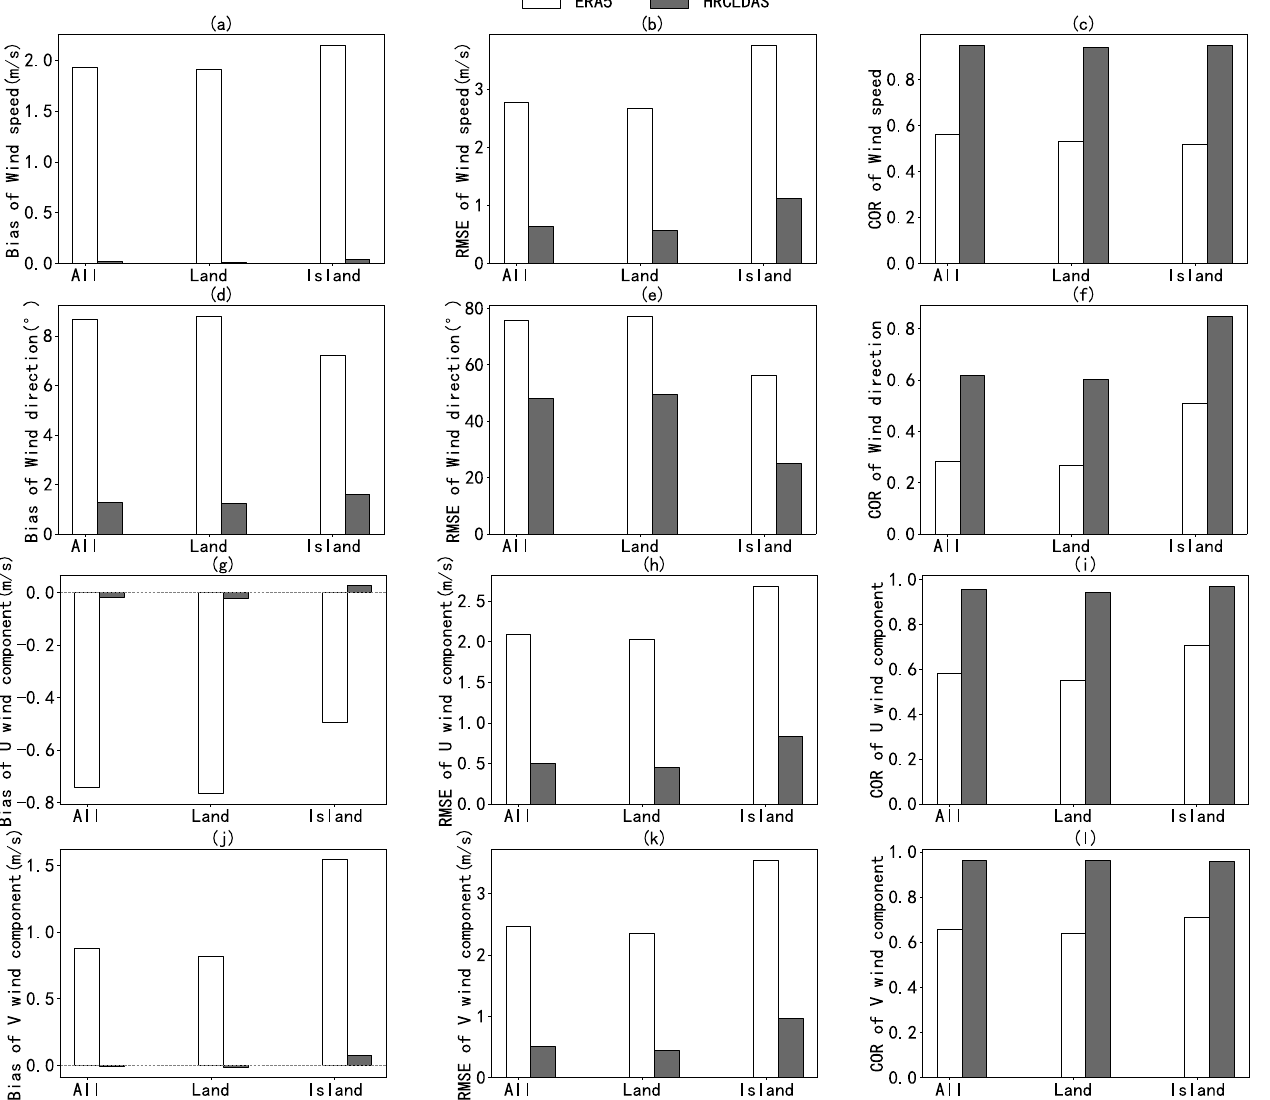
Figure 5. Evaluation indicators of ERA5 and HRCLDAS for land and sea. Bias of near-surface wind speed ( a ), wind direction ( d ), U component ( g ), and V component ( j ); RMSE of near-surface wind speed ( b ), wind direction ( e ), U component ( h ), and V component ( k ); COR of near-surface wind speed ( c ), wind direction ( f ), U component ( i ), and V component ( l ). For wind direction, ERA5 and HRCLDAS show a positive bias on land and the is- lands. The bias of ERA5 on land was higher than that on the islands, which were 8.78° and 7.22°, respectively. The bias of HRCLDAS on land was slightly smaller than that on the islands, which were 1.24° and 1.62°, respectively. The RMSEs of the two datasets were smaller on the islands than on land. The RMSEs of ERA5 on land and the islands were 77.2°and 56.3°, and those of HRCLDAS were 24.9°and 9.0°. The CORs of ERA5 on land and the islands were 0.27 and 0.51, respectively, and those of HRCLDAS were 0.60 and 0.85, respectively. For the U component, ERA5 had a negative bias on land and the islands, which were − 0.77 m s − 1 and − 0.50 m s − 1 , respectively, and the bias on land was greater than that on the islands. HRCLDAS had a negative bias on land with a value of − 0.02 m s − 1 , and it had a positive bias on the islands with a value of 0.03 m s − 1 . The RMSE and COR of the two datasets on land were both smaller than on the islands. For the V component, ERA5 had a positive bias on land and the islands, respectively, with values of 0.81 m s − 1 and 1.54 m s − 1 , and the bias on land was smaller than that on the